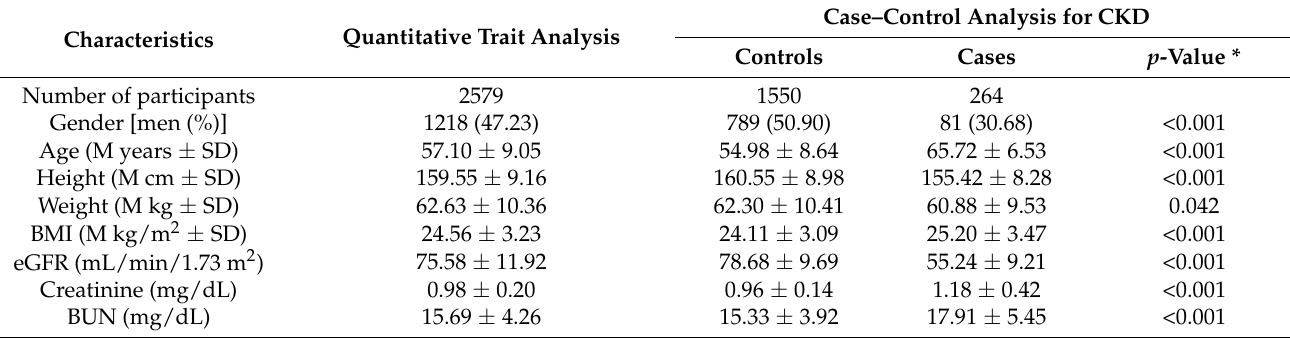
Table 1. Characteristics of participants in the Korean